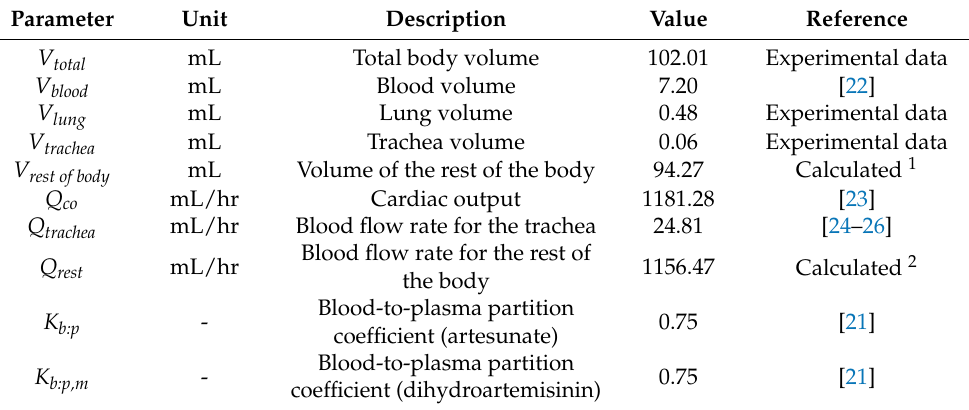
Table 1. Physiological parameters for developing the minimal PBPK